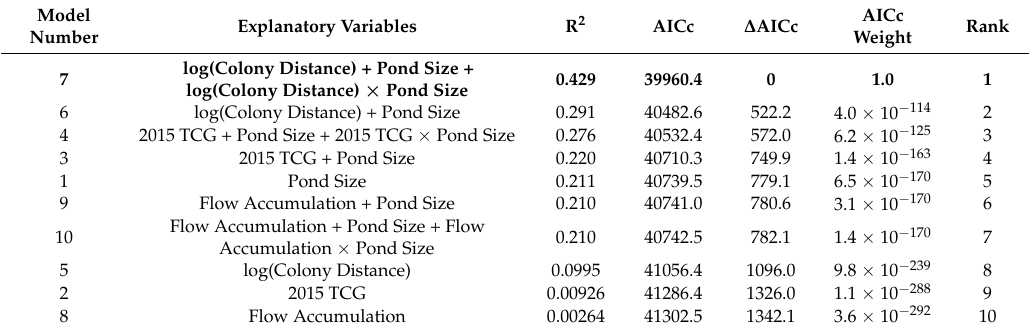
Table 4. Candidate models for change in waterbody area, with goodness-of-fit metrics. The table is ordered by the model fit, and the best model is shown in bold.